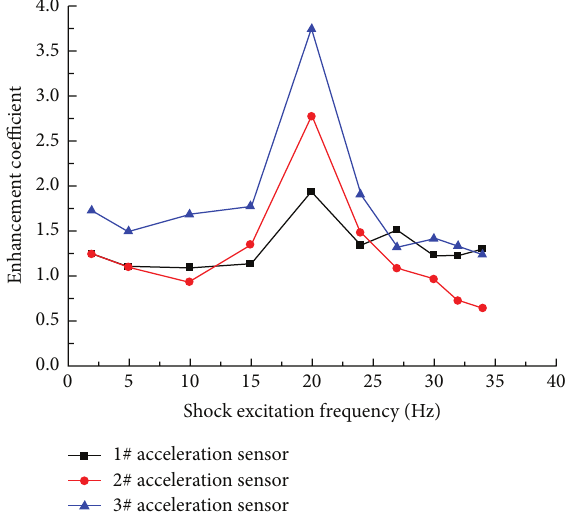
Figure 18: Enhancement coefficient curve of the acceleration response (0.5